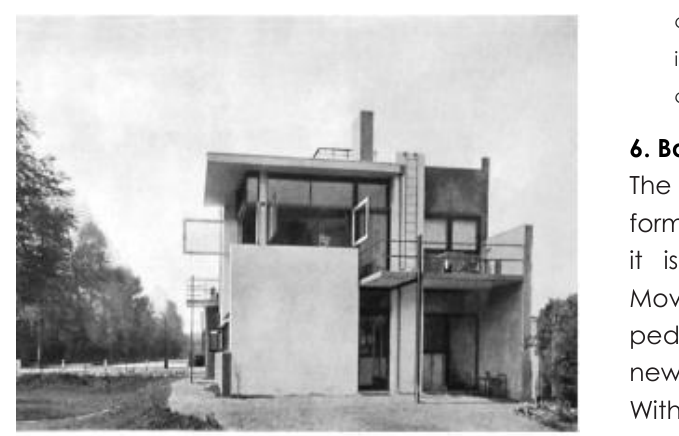
Figure 5 . Ludwig Mies van der Rohe Weissenhof Housign Project. (Pevsner, 1968).